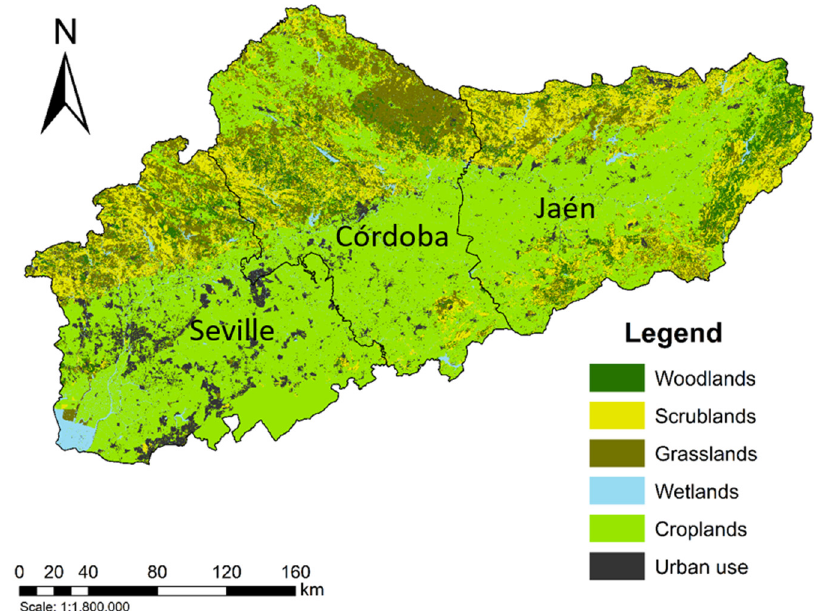
Figure 5. Territorial analysis map: land cover and use.